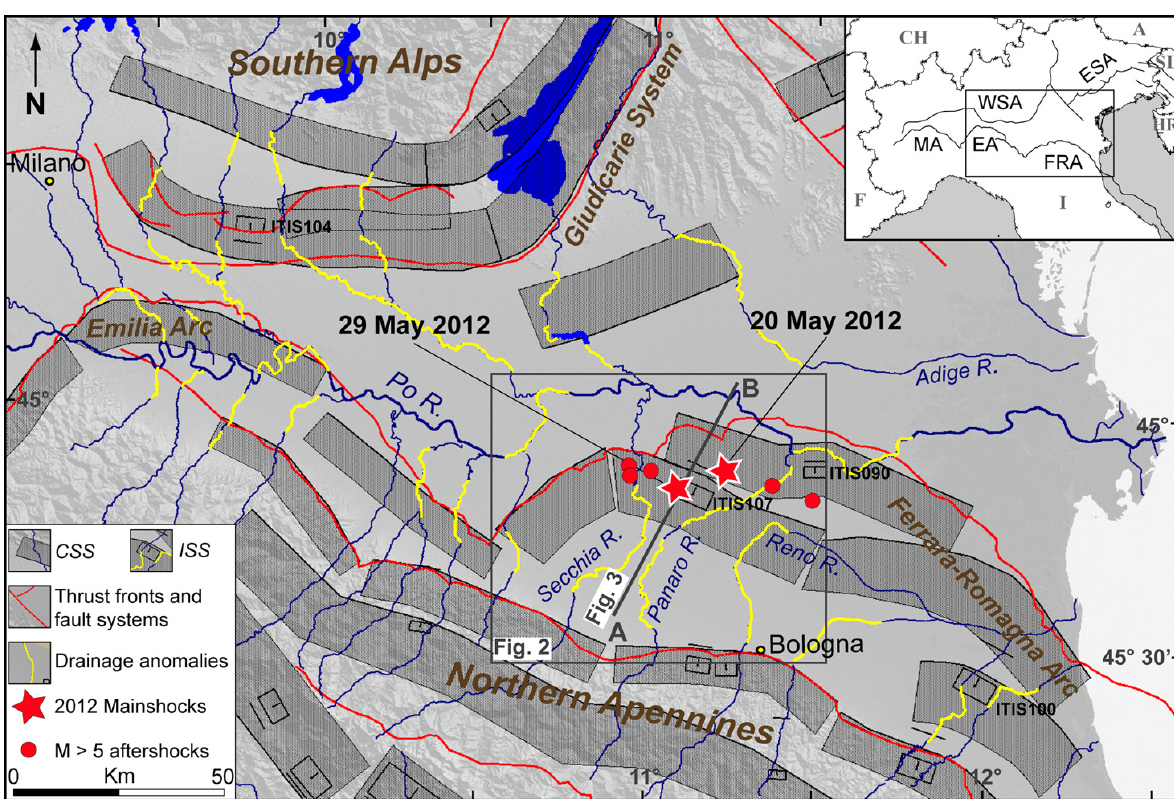
Figure 1. Seismotectonic sketch of the Po Plain and its fluvial system. Drainage anomalies are highlighted in yellow [from Burrato et al. 2003]. Red lines are the main thrust fronts or fault systems of the northern Apennines and southern Alps. Individual Seismogenic Sources (ISS) and Composite Seis- mogenic Sources (CSS) are from DISS 3.1.1. ITIS090, Ferrara Individual Source (http://diss.rm.ingv.it/dissHTML/ITIS090INF.html); ITIS107, Miran- dola Individual Source (http://diss.rm.ingv.it/dissHTML/ITIS107INF.html); MA, Monferrato Arc, EA, Emilia Arc; FRA, Ferrara-Romagna Arc; WSA, western southern Alps; ESA, eastern southern Alps. Boxed area, detail shown in Figure